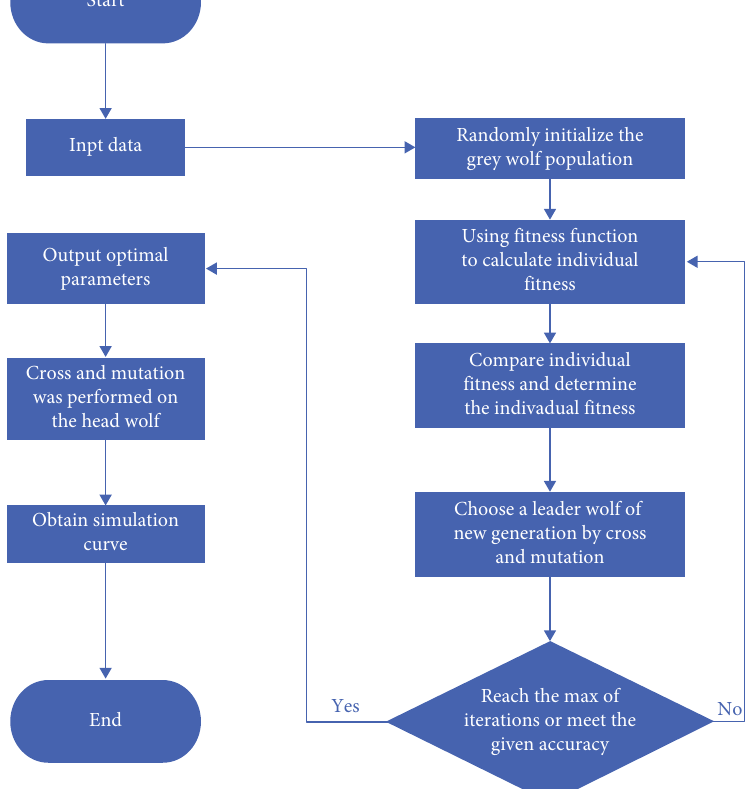
Figure 1: Algorithm fl ow